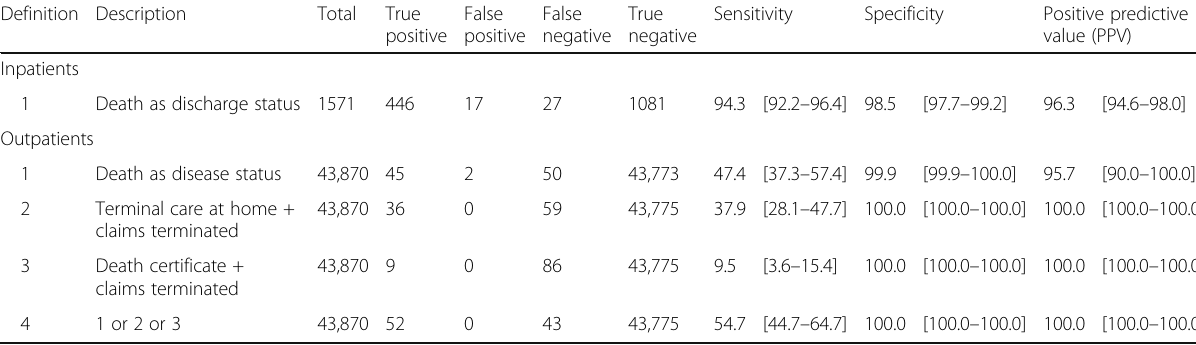
Table 2 Sensitivity and specificity of the claims-based definition of death Definition